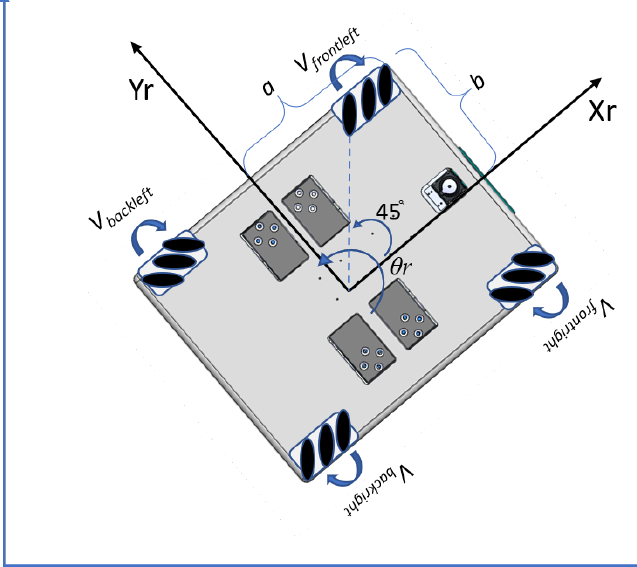
Figure 2. WASP: Kinematic motion